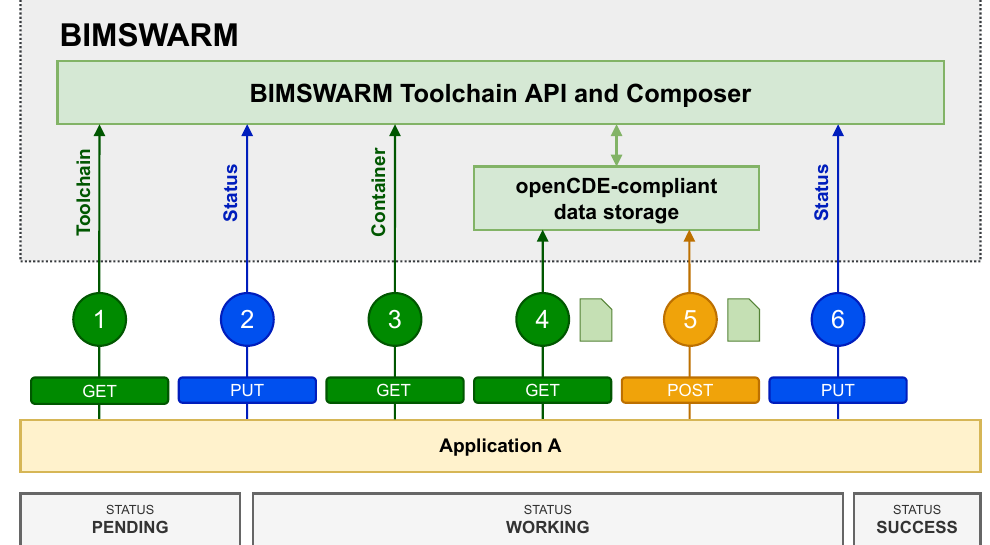
Figure 8. Schematic representation of the calls to the BIMSWARM API and the openCDE-compliant web interface. The documentation of the specified interfaces and calls is available online